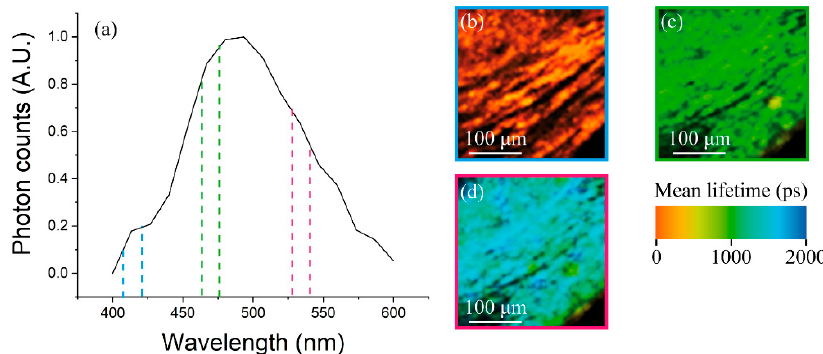
Figure 10. ( a ) The spectrum acquired with the 16 channels of the PML-Spec Multi-PMT, ( b – d ) the false colors FLIM images acquired in the second, sixth and eleventh channels, which correspond to SHG emission from collagen fibers, TPEF from elastin and collagen, and TPEF from smooth muscle cells, respectively.